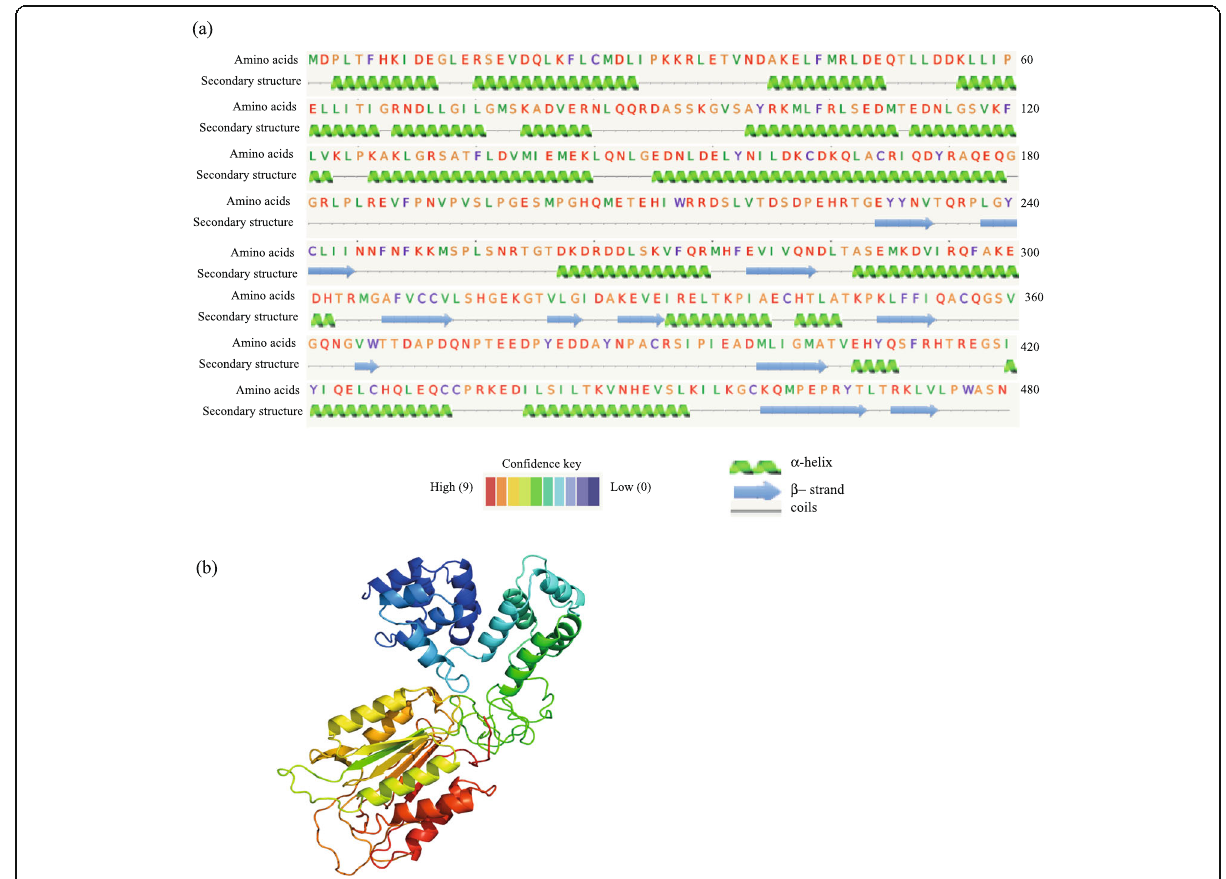
Fig. 2 Structure of Lrcasp8 protein. a The secondary structure of Lrcasp8 protein was predicted by PHYRE 2.0 program. The α -helix region is shown with “ spiral, ” β -strands with “ arrow, ” and the coil with “ straight line. ” b The 3D model of Lrcasp8 was predicted by PHYRE 2.0 program. The α -helix region is shown with “ spiral ribbon, ” β -strands with “ arrow, ” and the connection loops with “ coil